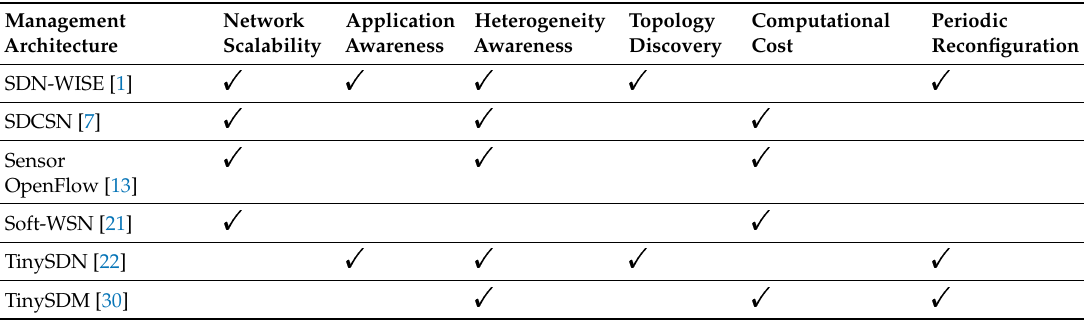
Table 1. Summarized review of SDN-based sensor